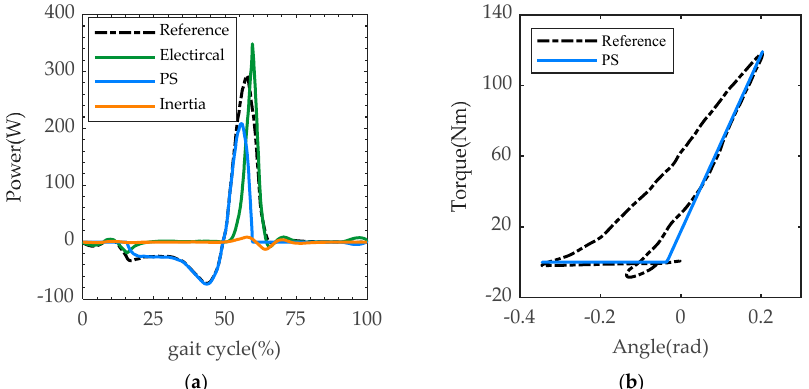
Figure 2. Simulation result of the optimization. ( a ) Power results of the simulation, where the reference power (black), motor power (green) and parallel spring power (blue) are plotted along the gait cycle. ( b ) Reference data of the able-body (black) from [4] and the optimal result of the parallel spring stiffness